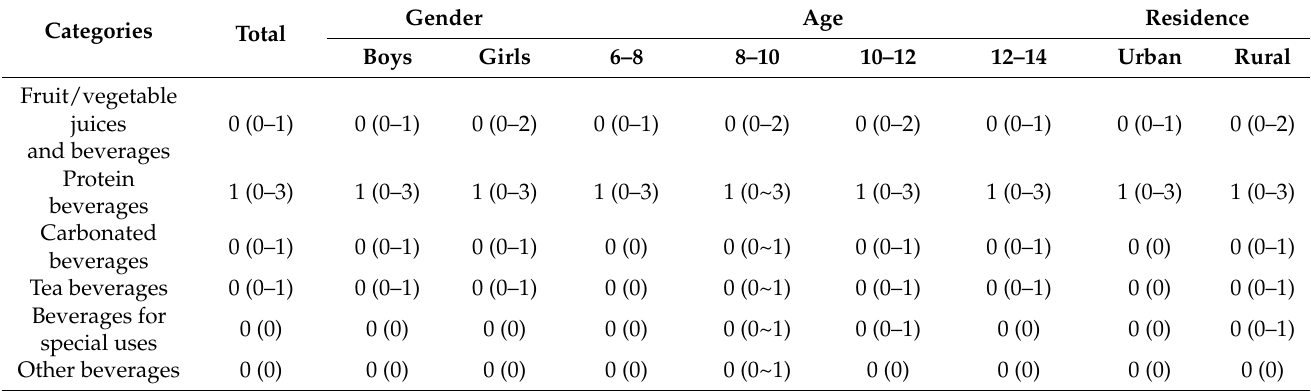
Table A5. Description of beverage consumption frequency among students (times/week, P50 (IQR)).